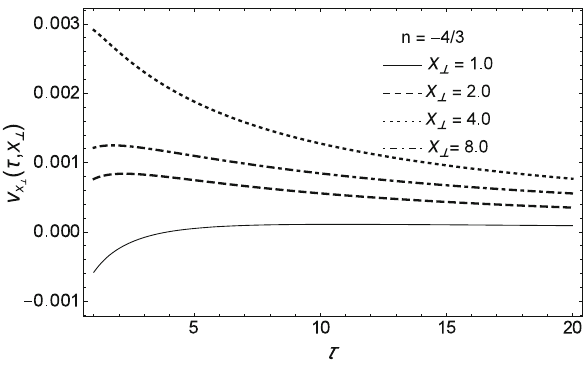
Fig. 14 v x ⊥ as a function of τ for different values of x ⊥